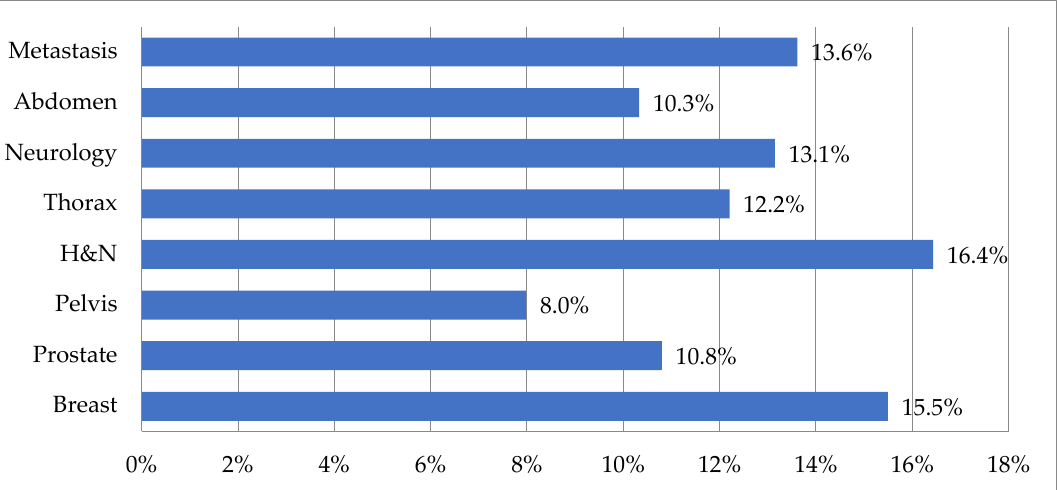
Figure 2. Ranking of localizations based on their time ‐ saving potential—Focus on 6–8 rankings.